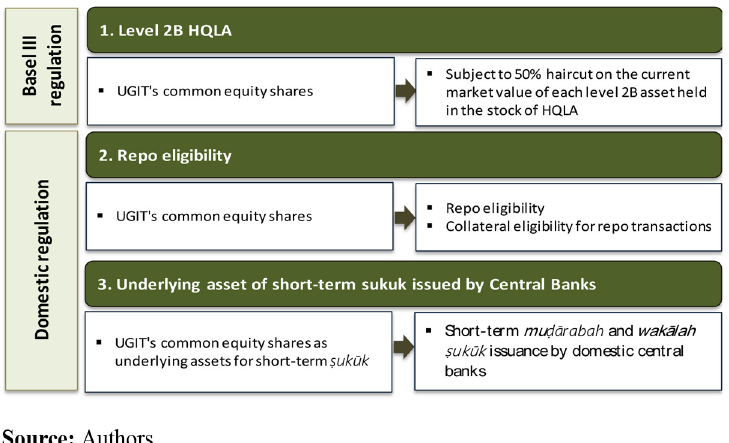
Figure 3. UGITs ’ three-layer solution for